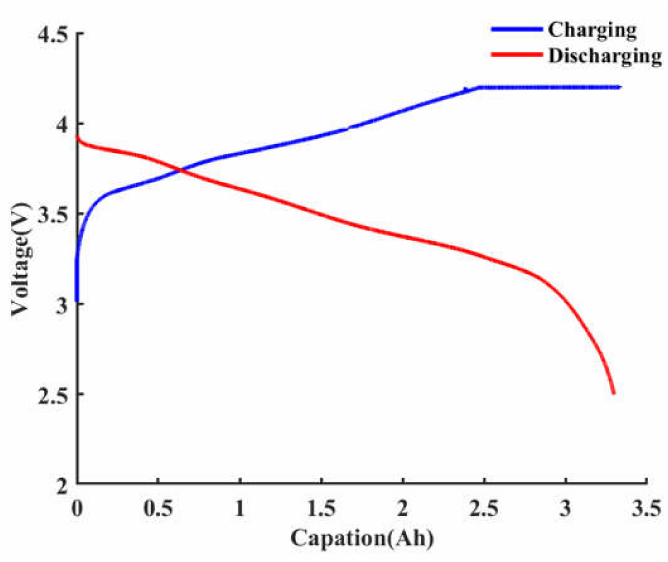
Figure 2. The charging and discharging curves of the battery.